Question: What does this figure show? Answer in one sentence.
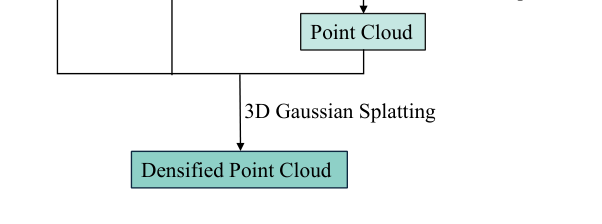
Answer: Flowchart of HoloGS: Via the HoloLens 2 sensor streaming, the required data is directly extracted and processed during data capturing. From the depth data, a point cloud is in- stant created which, together with the RGB images and corres- ponding camera poses, is then fed into 3D Gaussian Splatting.